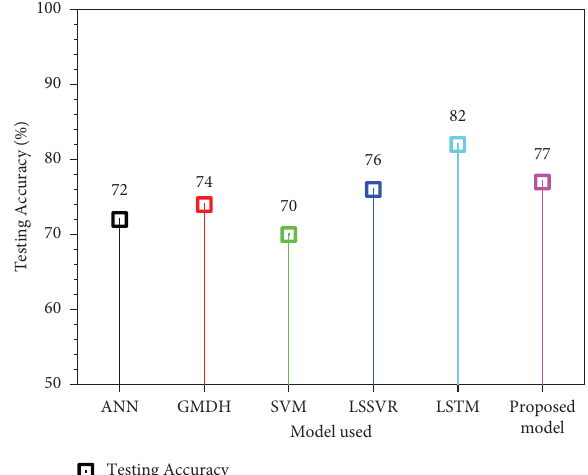
Figure 5: Comparison of testing accuracy of the diferent